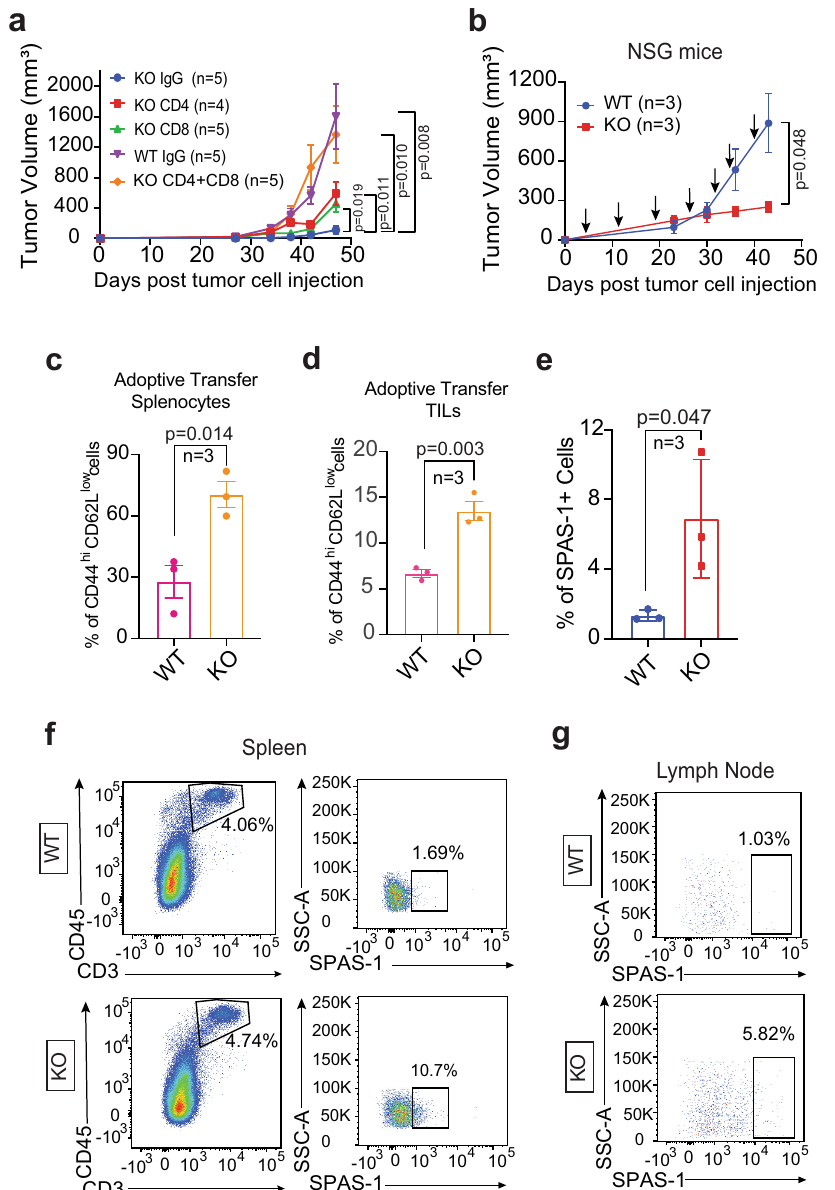
Fig. 6 | ACK1 knockdown instigates T cell recruitment restraining tumor growth.a TRAMP-C2cellswereimplantedsubcutaneouslyinWTand Ack1 KOmale mice. Anti-CD4 or Anti-CD8 (or IgG ascontrol) depletion antibodies were injected, andtumorvolumesweremeasuredwithcalipers( n =5miceinKOIgG,KOCD8,KO CD4+CD8 and WT IgG; n =4 in KO CD4 group). b – g Adoptive transfer of Ack1 KO and WT T cells into tumor bearing NSG mice. TRAMP-C2 cells were implanted subcutaneouslyinNSGmice.Adoptivetransferofpuri fi edTcellsfromWTand